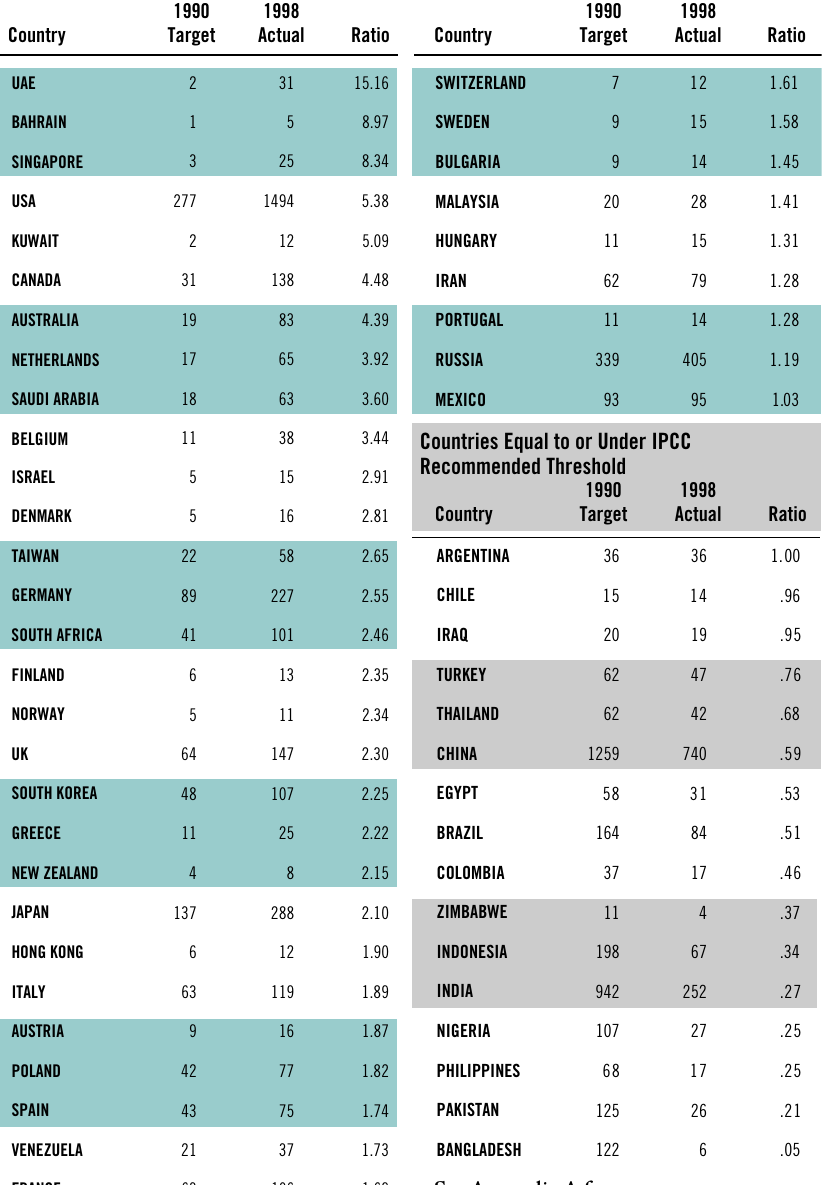
Table 2 – Comparison of 1990 Target Carbon Emissions Rates to Actual 1998 Carbon